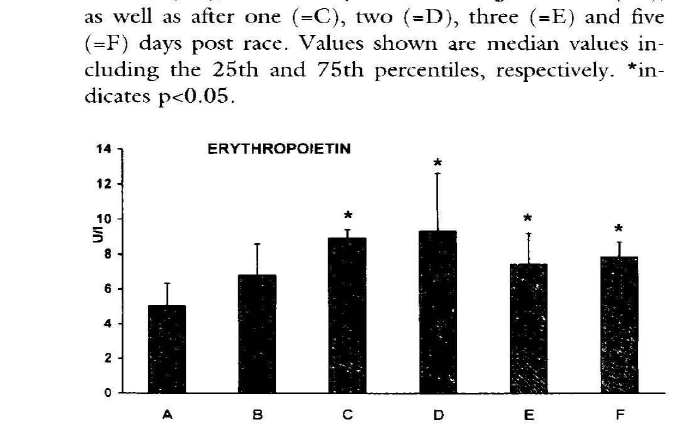
hgure -t. Tim.: course of enothropoietin at the Oetztal bic\'cle